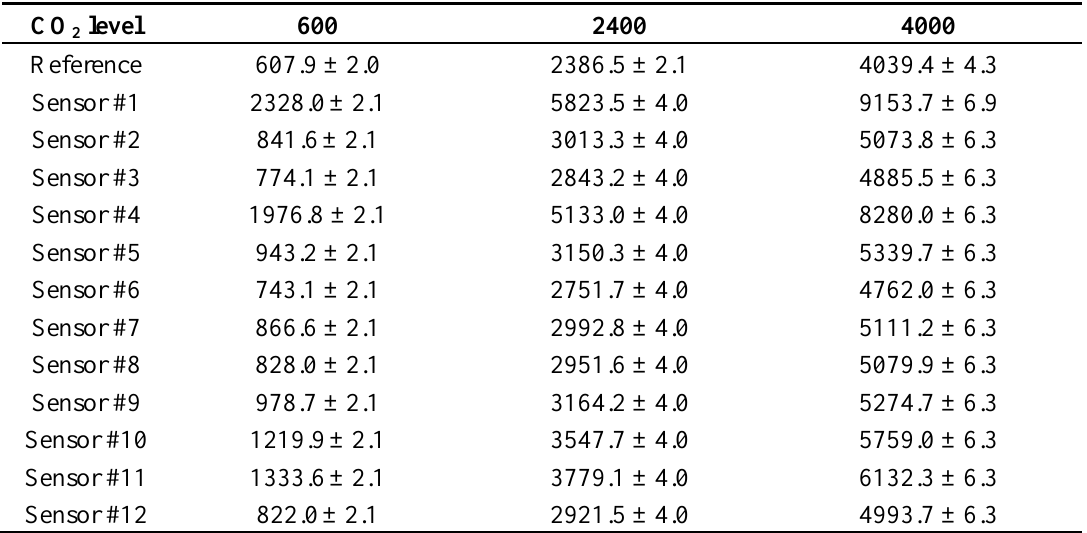
Table 3. Sensor readings (average ± standard deviation) at three different CO Concentrations obtained by the reference analyzer are also shown. Units are expressed in